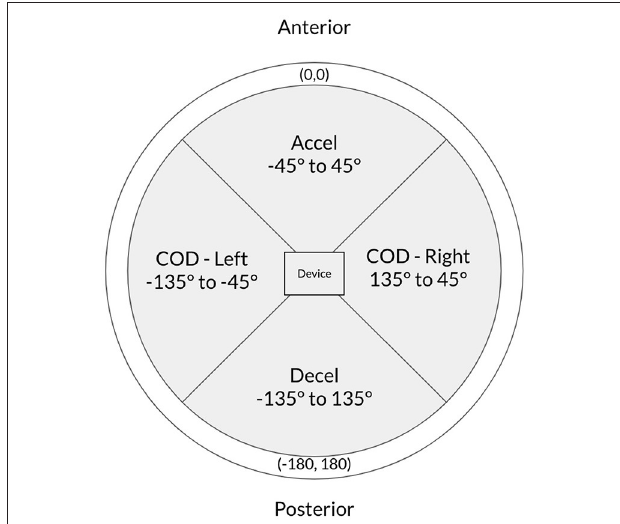
FIGURE 1 | Directional graph of IMA